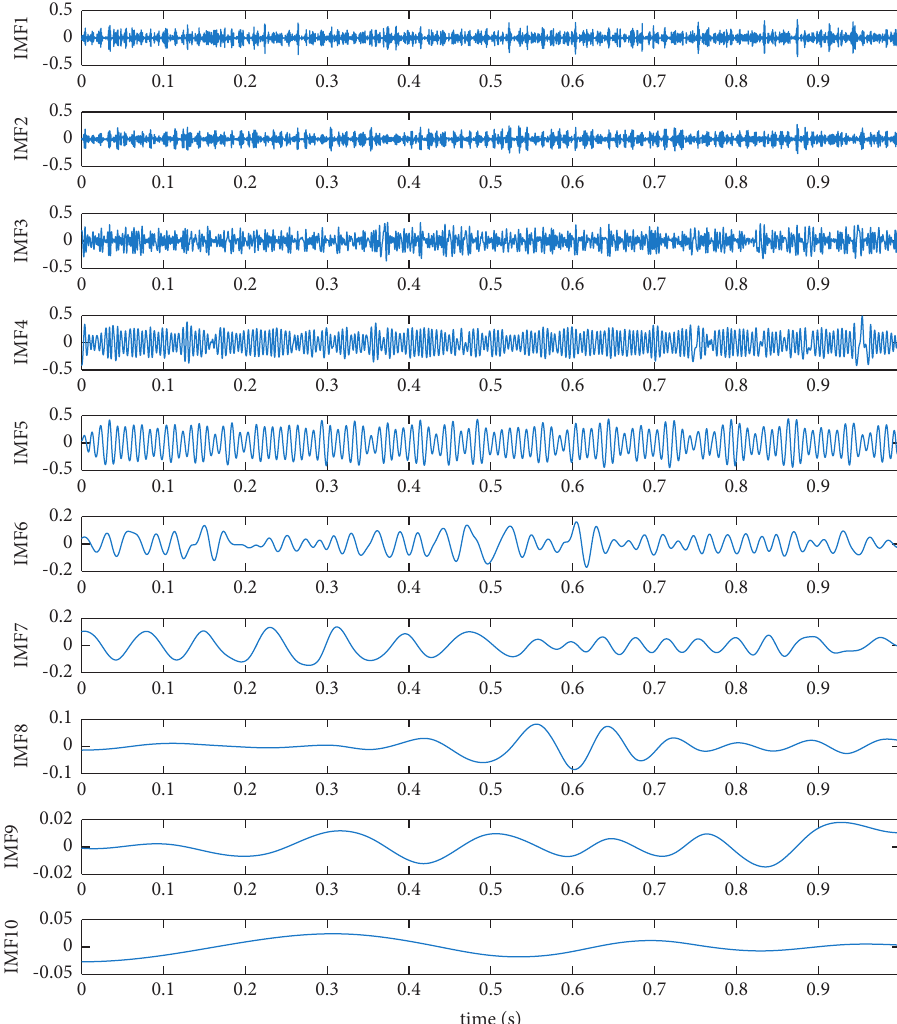
Figure 12: ICEEMDAN decomposition of the experimental outer ring fault